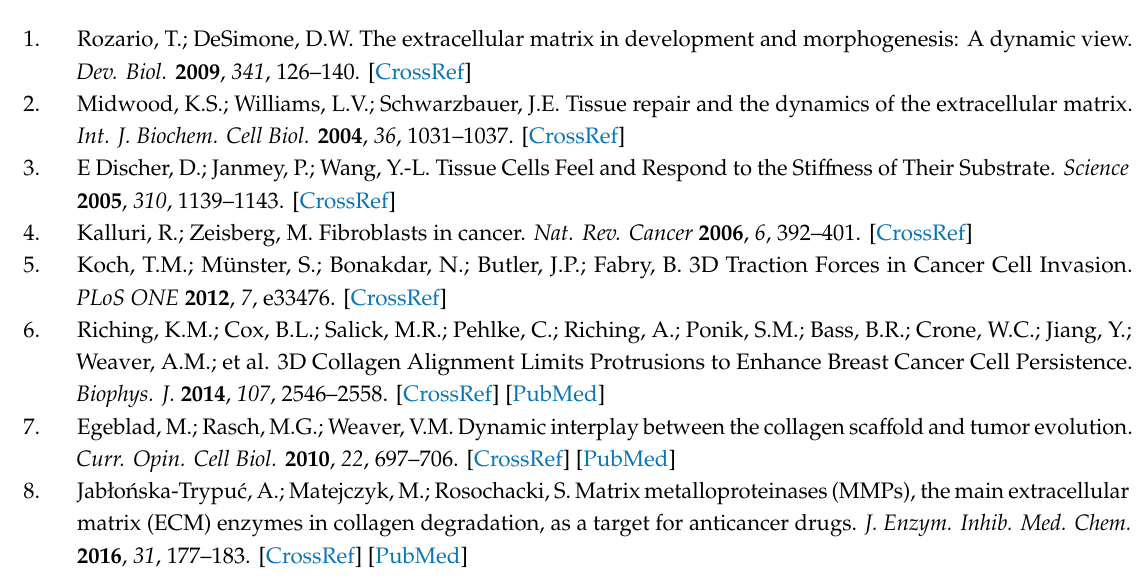
Figure S1: Transversal sampling rate optimization with a physically translated sample, Video S1: Dynamic interaction between two distant HUVECs through ECM over time, Source code S1: RANSAC plane fitting script for 3-D OCM image, and Source code S2: Visualization demo of DVC result with OCM